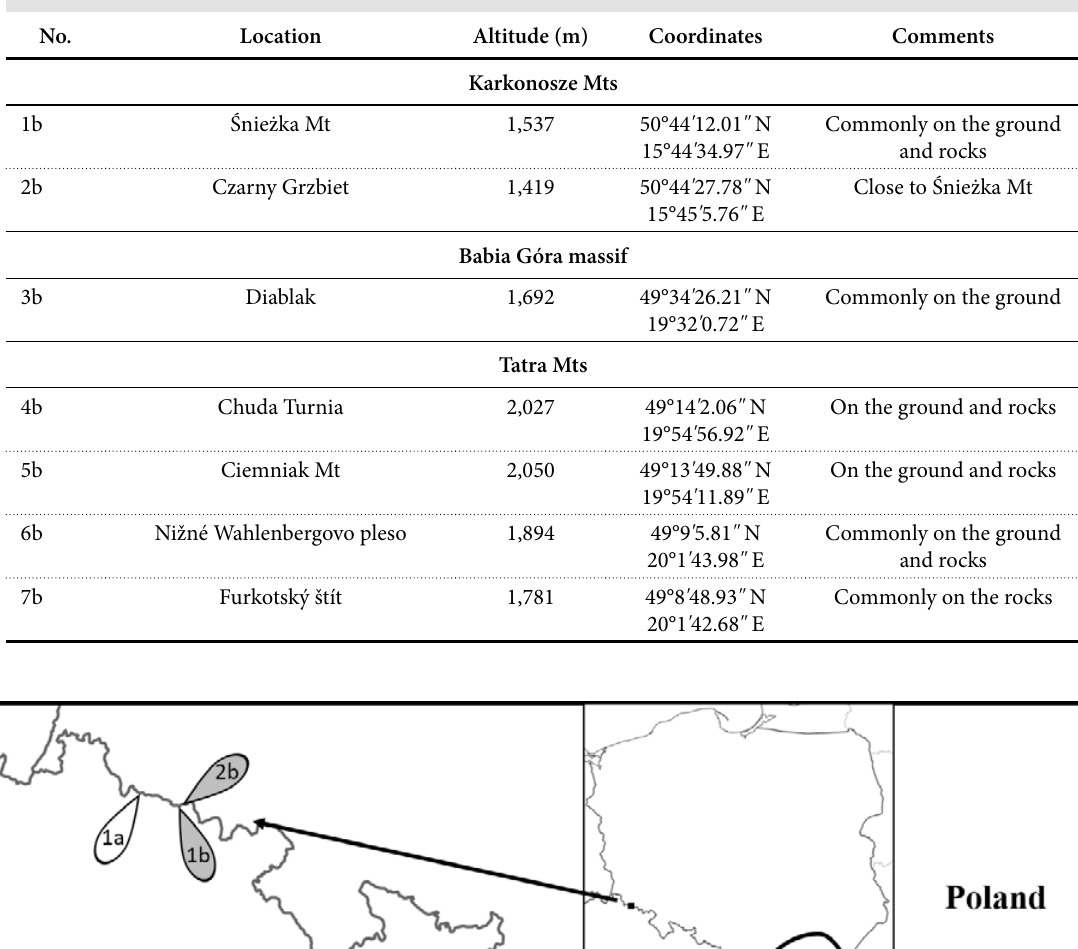
Tab. 2 Locations of studied J. trifidus populations.